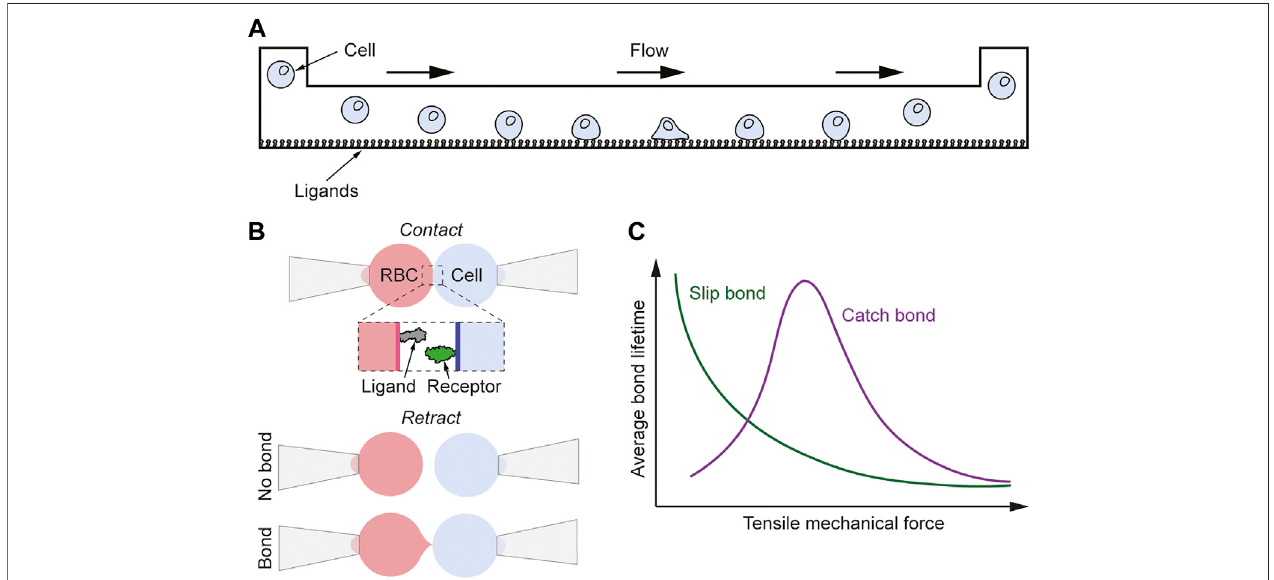
FIGURE 4 | Mechanical-based methods for measuring binding kinetics of ligand-receptor interactions. (A) Schematic of the fl ow chamber method. A cell in the ligand-functionalized fl ow chamber adheres to the surface for a certain time allowing for the 2D binding kinetics of the interaction to be measured under different fl ow/ forceconditions. (B) Schematicoftheadhesion frequency assay.Abondisdetected asadeformationoftheRBCwhen thetwocellsareretractedfromeach other,and from the adhesion probability at different contact times the binding kinetic can be determined. (C) Schematic graph showing the lifetime vs force behavior for slip and catch